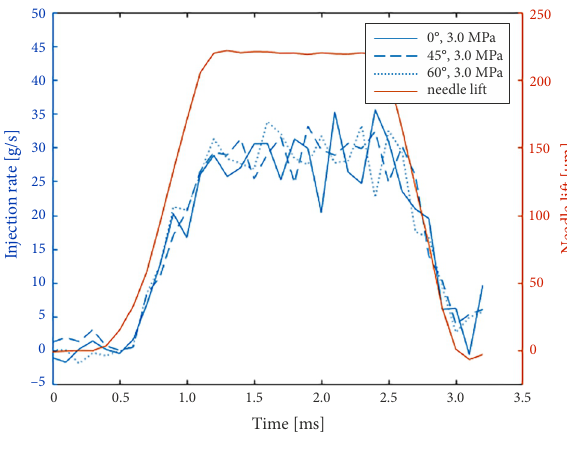
Figure 9. Measured injection rates and needle lift for 1500 min –1 , 200 N ⋅ m, 3 MPa backpressure, with different plug valve positions